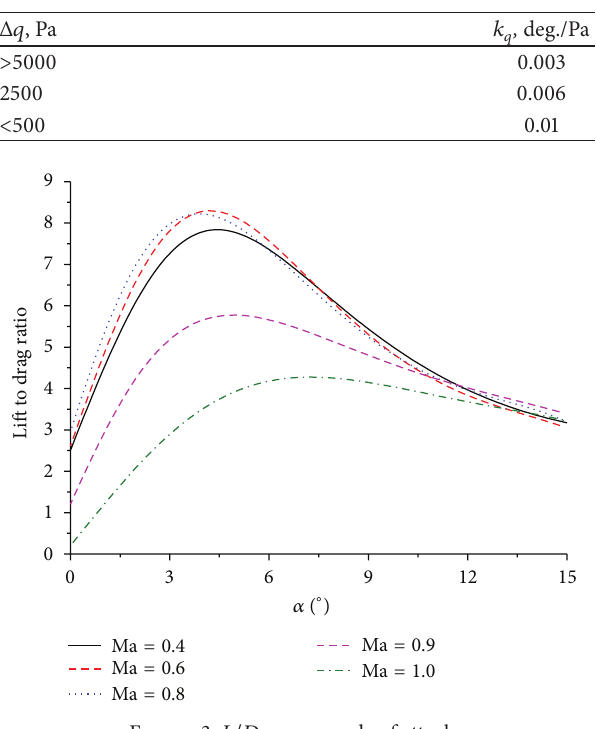
Table 1: 𝐿/𝐷 max and drag coefficient in different Mach numbers.